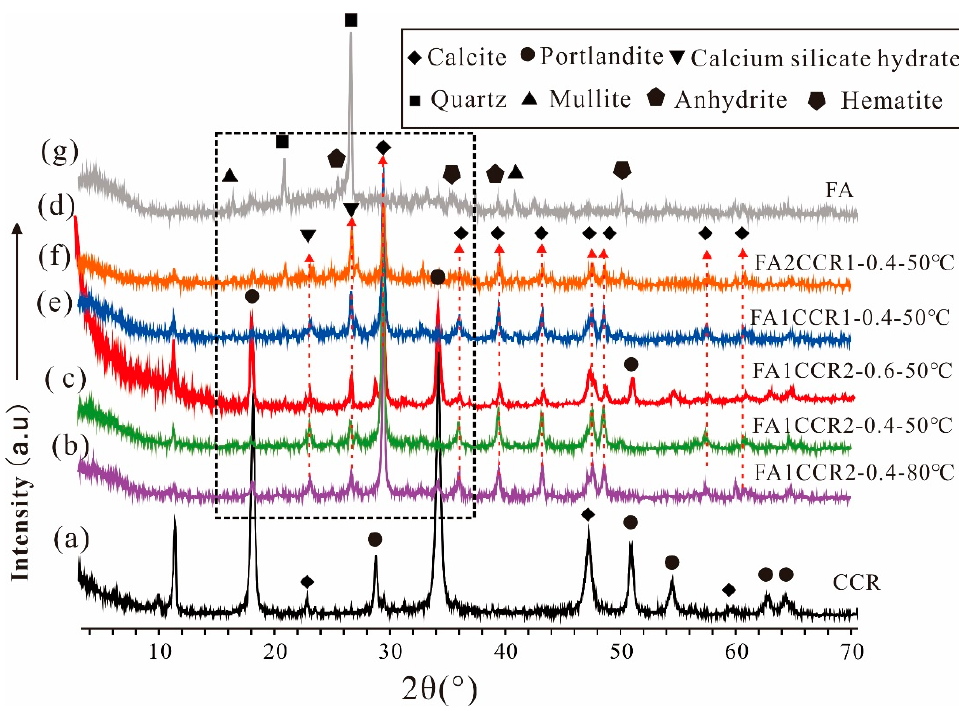
Figure 3. The XRD patterns of raw materials and FA/CCR-based geopolymers. ( a ) CCR; ( b ) FA1CCR2-0.4-80 °C; ( c ) FA1CCR2-0.4-50 °C; ( d ) FA1CCR2-0.6-50 °C; ( e ) FA1CCR1-0.4-50 °C; ( f ) FA2CCR1-0.4-50 °C; ( g ) FA.